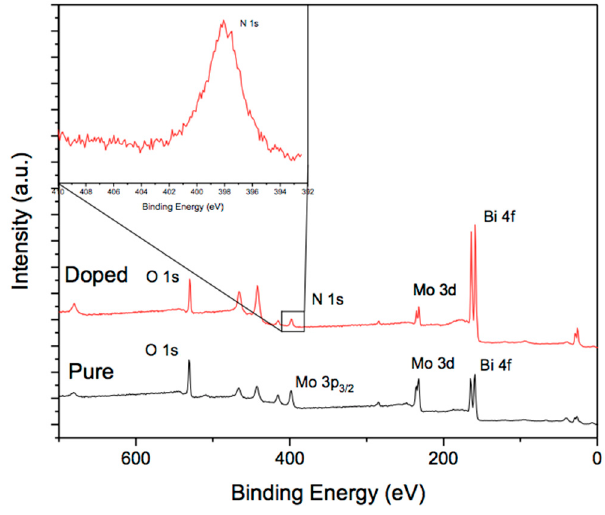
Figure 6. XPS analysis for Bi 2 MoO 6 and N-Bi 2 MoO 6 catalysts.